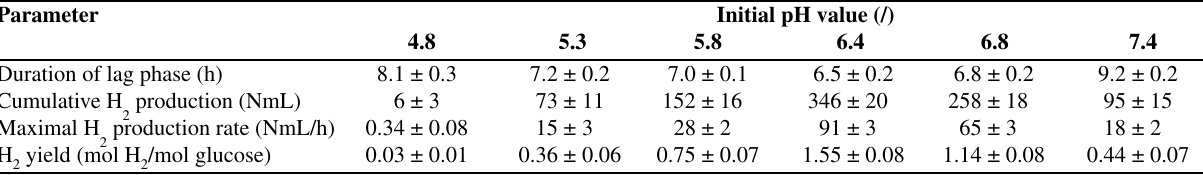
Table 2. Performance of hydrogen production by anaerobic sludge fermentation at different initial pH values. Parameter